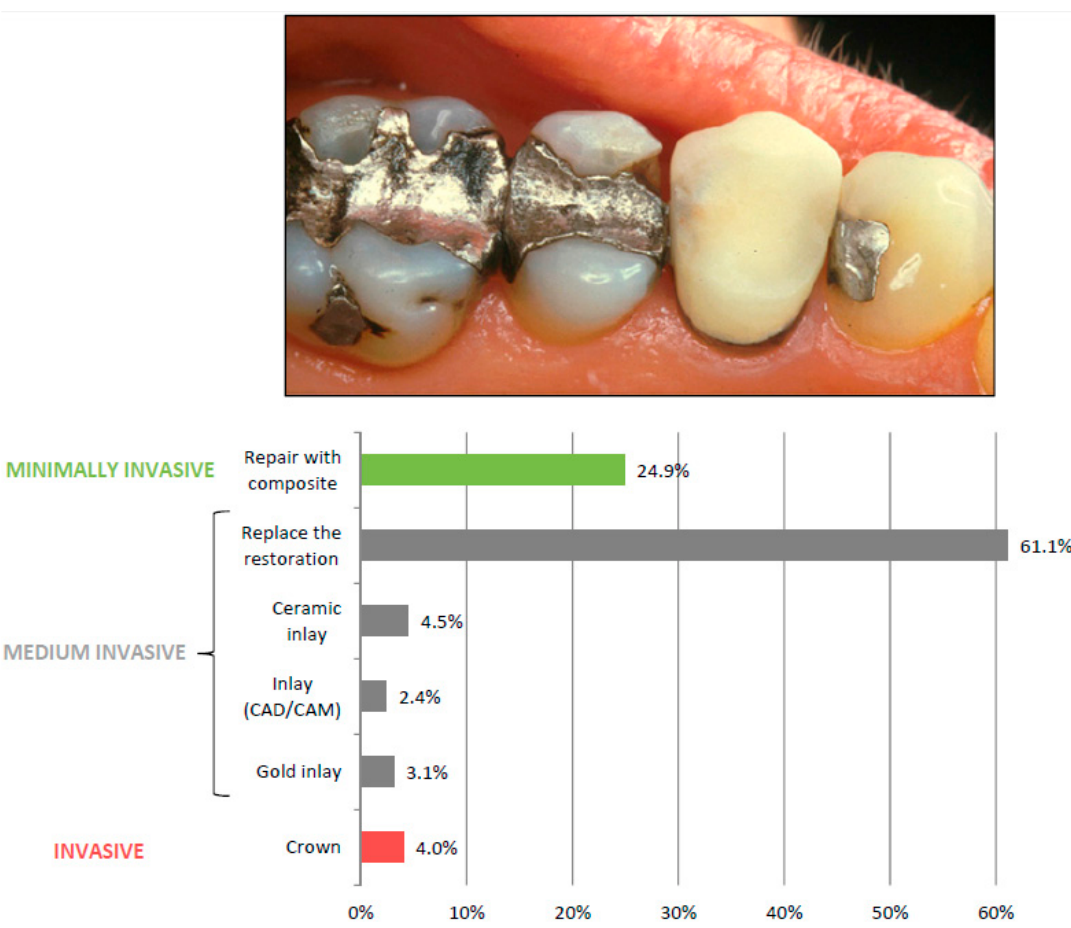
Figure 2. Patient Case 2 : What is in your opinion on the best treatment for this upper second premolar? The tooth has a fractured amalgam restoration. There is no sign of secondary caries. The restoration has cervical enamel in both the approximal boxes. Radiological examination shows that the amalgam restoration has good distance to the pulp. No other pathology is noticed. The patient is a 52-year-old woman with low caries activity and normal occlusion. She has no aversion towards amalgam and there are no economical limitations regarding the choice of treatment.